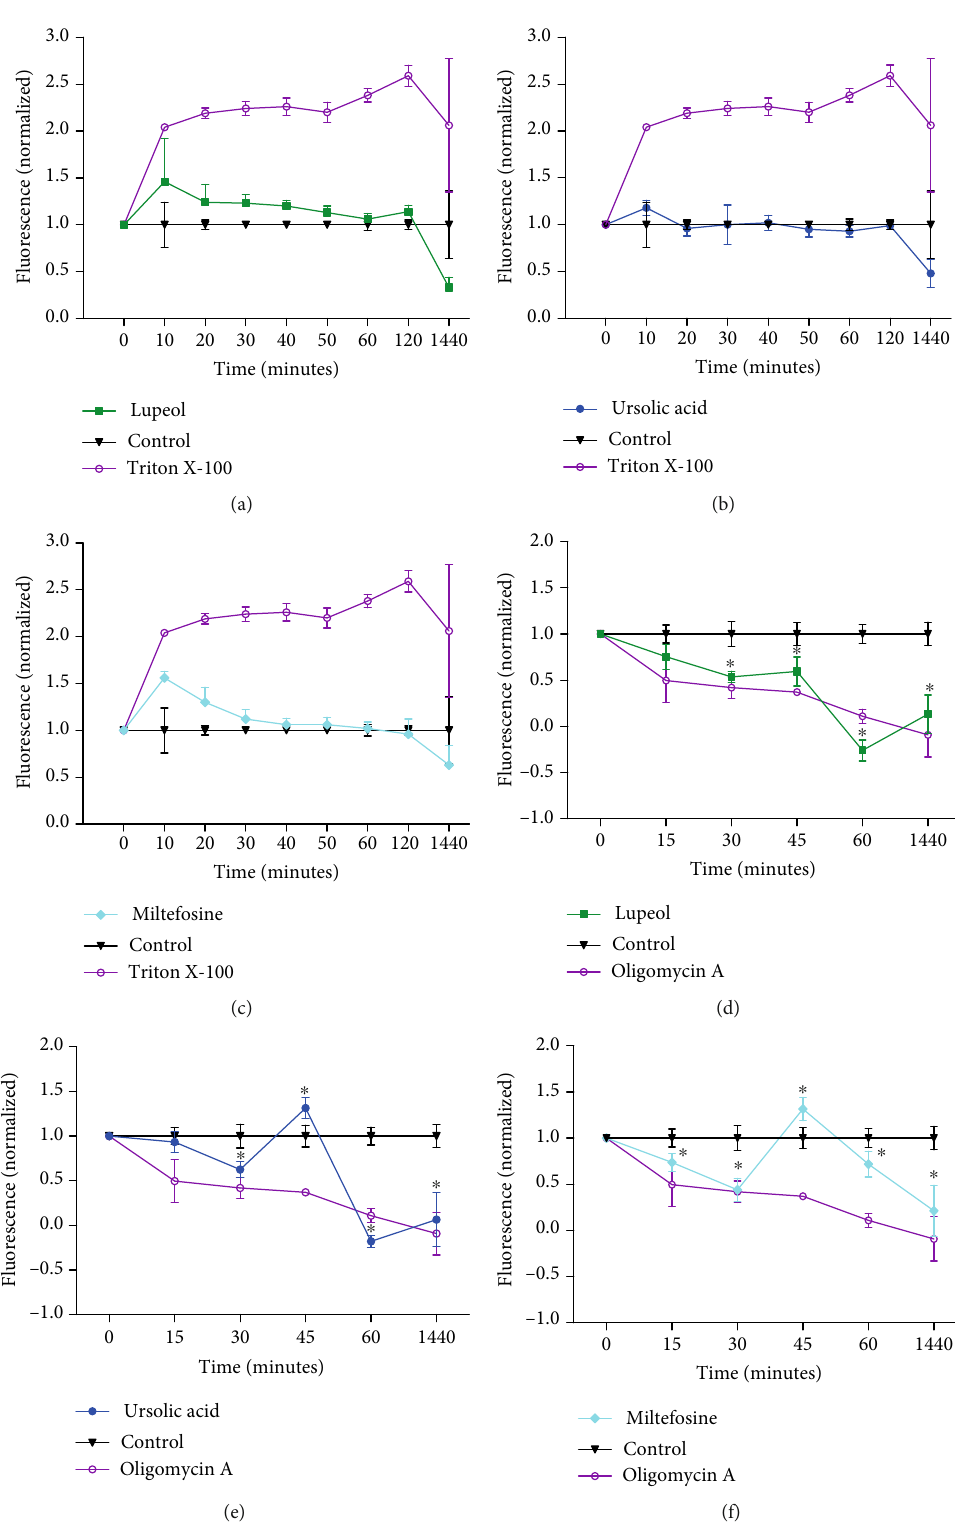
Figure 6: Cell membrane integrity and mitochondrial membrane potential assays of L. ( L. ) infantum promastigotes. Parasites were treated with Lu (a), UA (b), and miltefosine (c) at the IC and at di ff erent time points, the probe SYTOX® Green (0.5 μ M) was added, and the 50 fl uorescence intensity was analyzed. Triton X-100 was used as a positive control. In (d – f), promastigote forms were incubated with the IC s of the Lu, UA, and miltefosine, respectively, and at di ff erent time points, Rhodamine 123 probe (3 μ M) was added to the parasites, 50 and the fl uorescence intensity was analyzed. Oligomycin A was used as a positive control. Fluorescence was normalized relative to the control